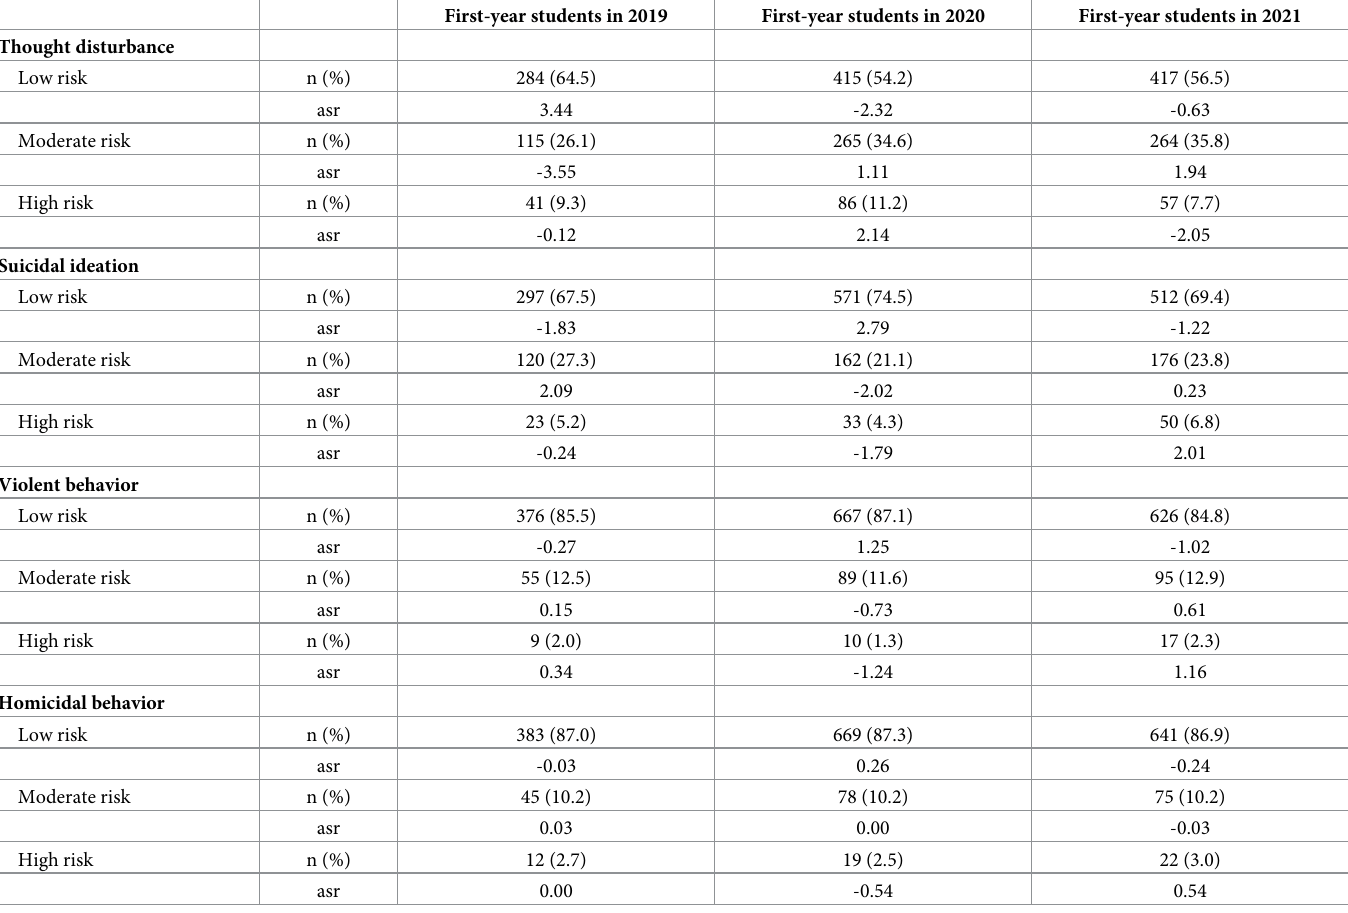
Table 5. Results of comparing the CCAPS–Japanese critical items for 2019, 2020, and 2021 first-year